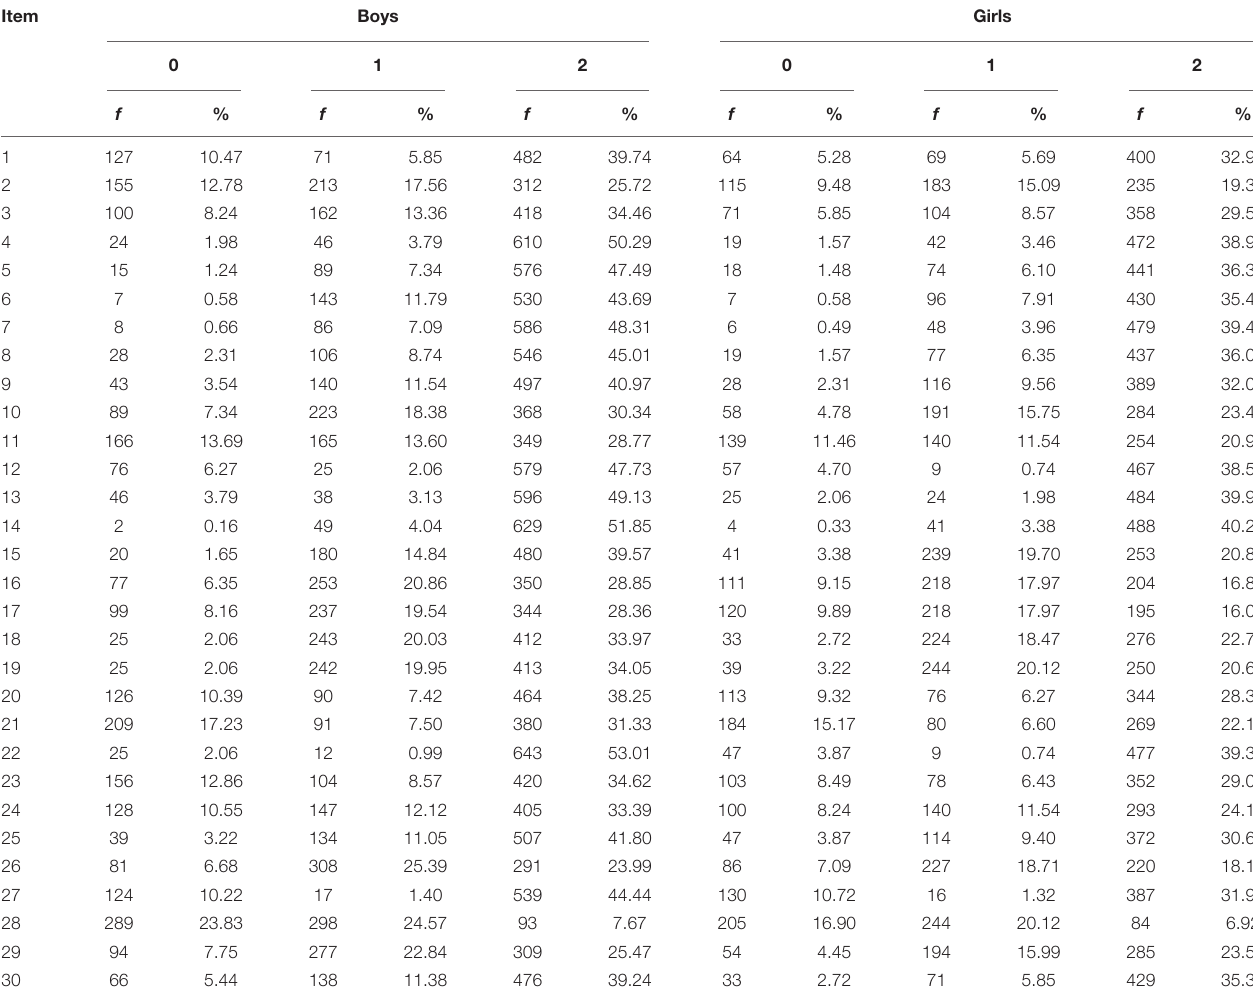
TABLE 9 | Frequencies and percentages by sex from students with level 3 performance.